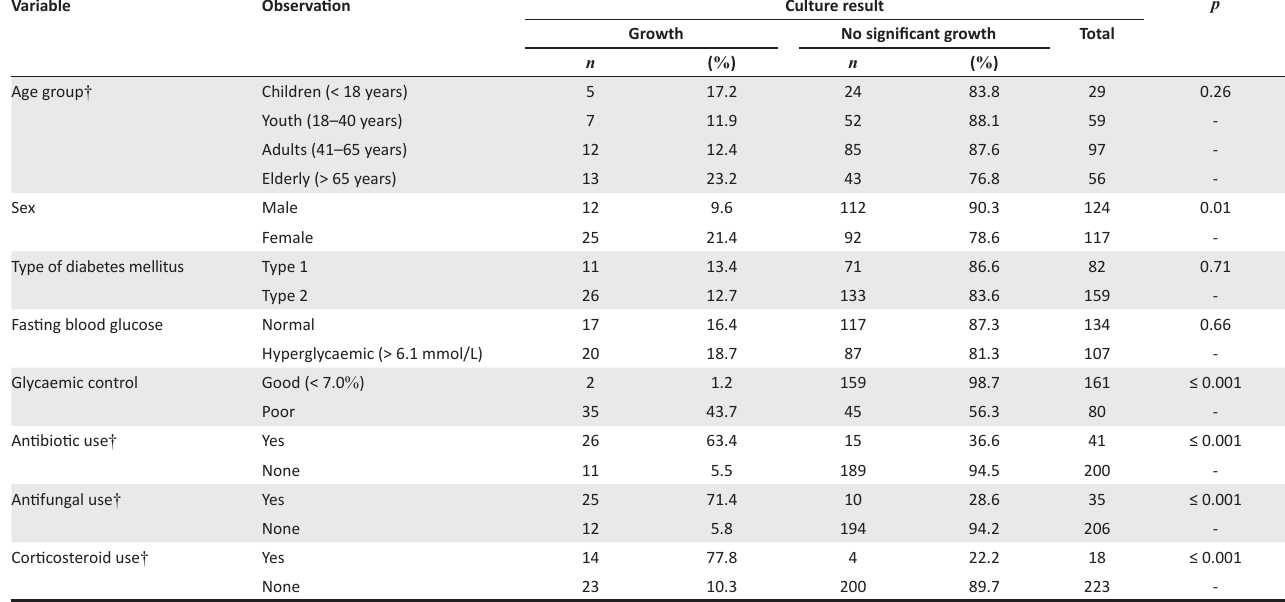
TABLE 3: Relationship between patient factors and gastrointestinal candidiasis ( n = 37), Kampala, Uganda, March 2017 to December 2017. Variable